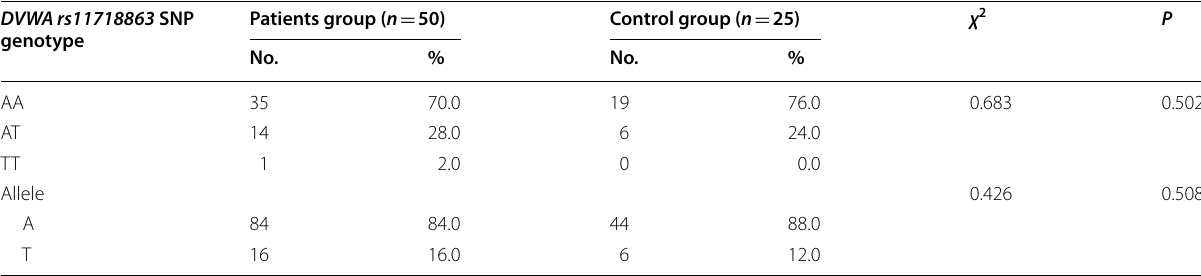
DVWA double Von Willebrand factor domain A, P P value for comparison between the studied groups, SNP single nucleotide polymorphism, χ 2 value of chi-square test, % percentage of patients or healthy volunteers *Statistically significant at P ≤